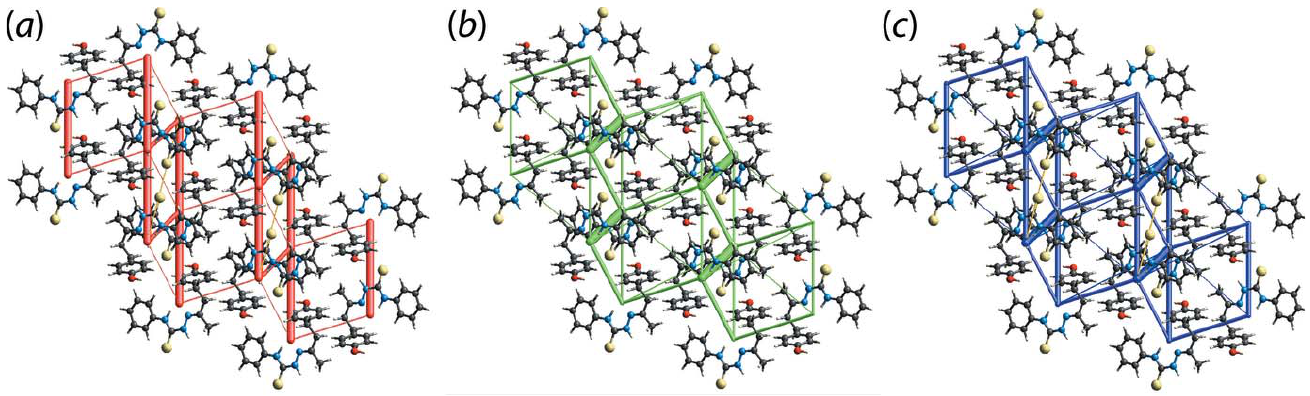
Figure 8 Perspective views of the energy frameworks calculated for (I) showing ( a ) electrostatic potential force, ( b ) dispersion force and ( c ) total energy, each plotted down the a axis. The radii of the cylinders are proportional to the relative magnitudes of the corresponding energies and were adjusted to the same scale factor of 55 with a cut-off value of 5 kJ mol (cid:3) 1